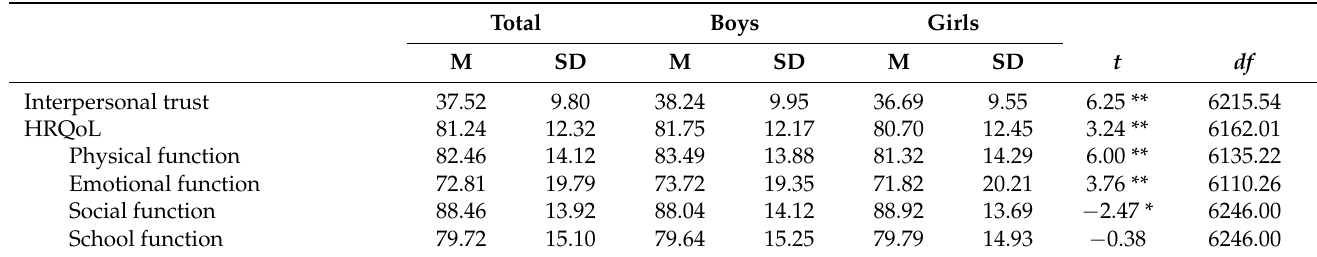
Table 2. Means and standard deviations of study variables.